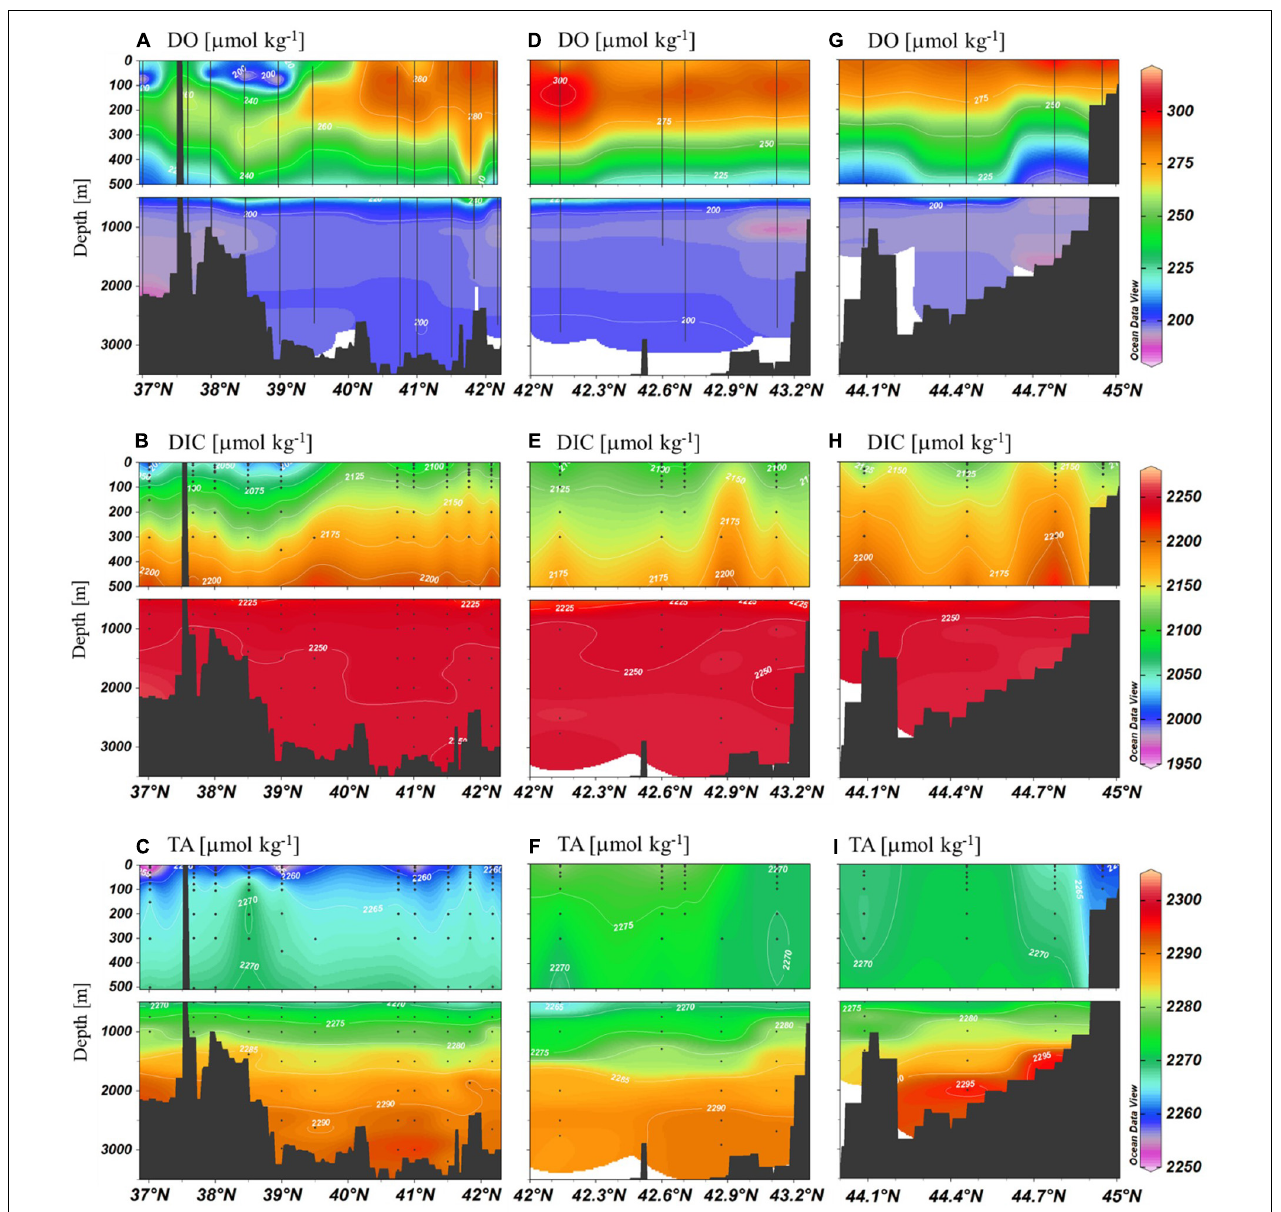
FIGURE 3 | Meridional sections of DO, DIC, and TA along the three transects in Figure 1 observed in 2019.